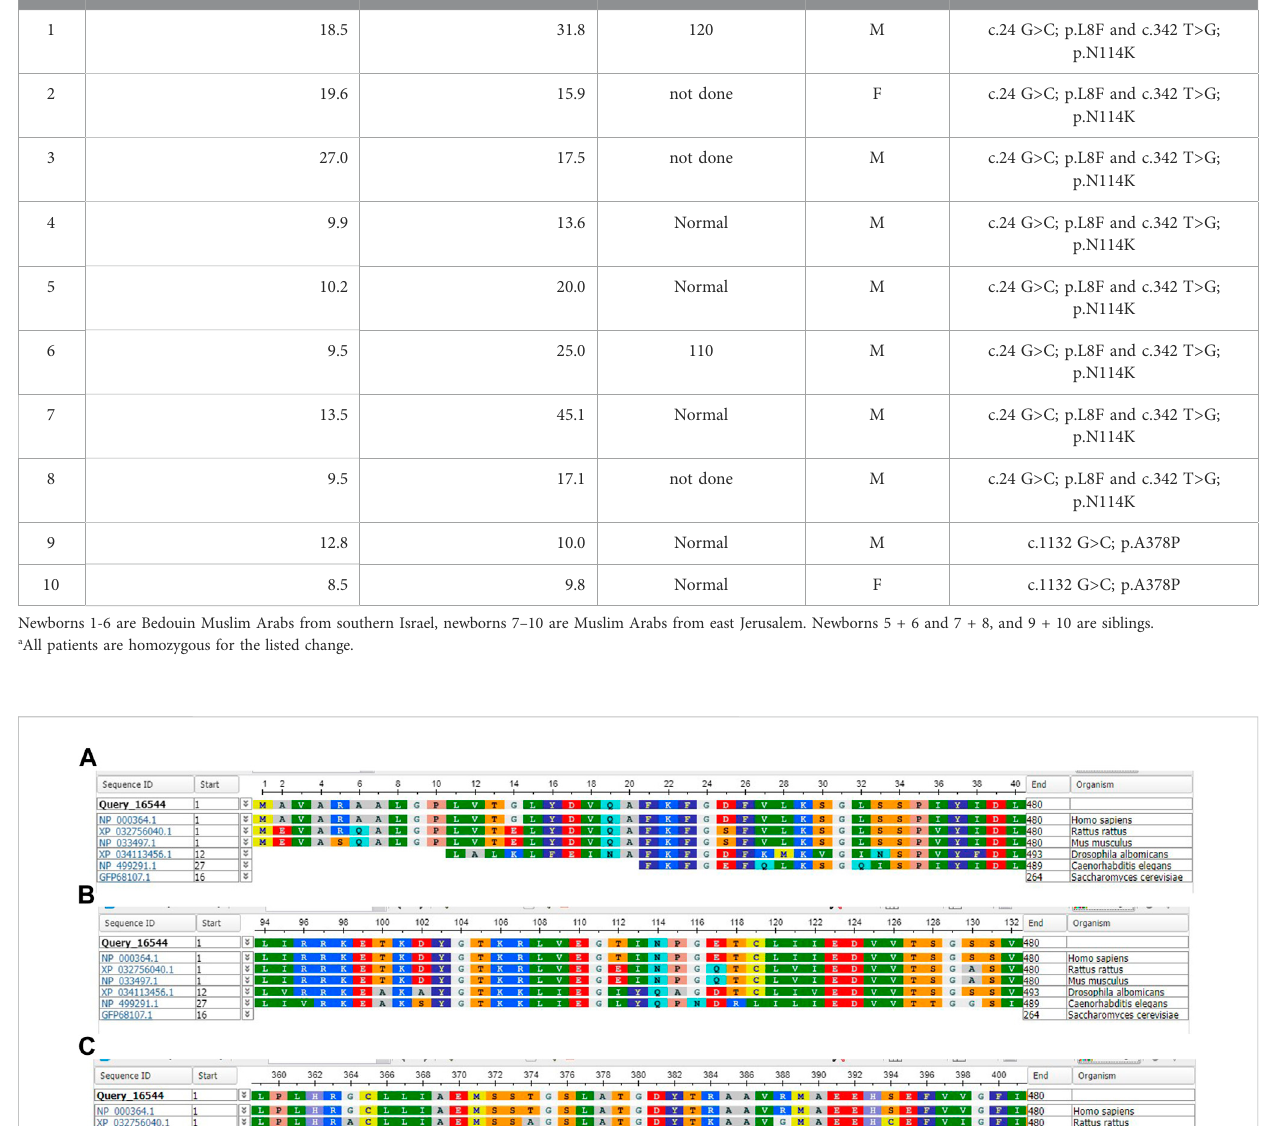
TABLE 1 Biochemical fi ndings and UMPS genotype in hereditary orotic aciduria subjects identi fi ed by routine newborn screening. No.